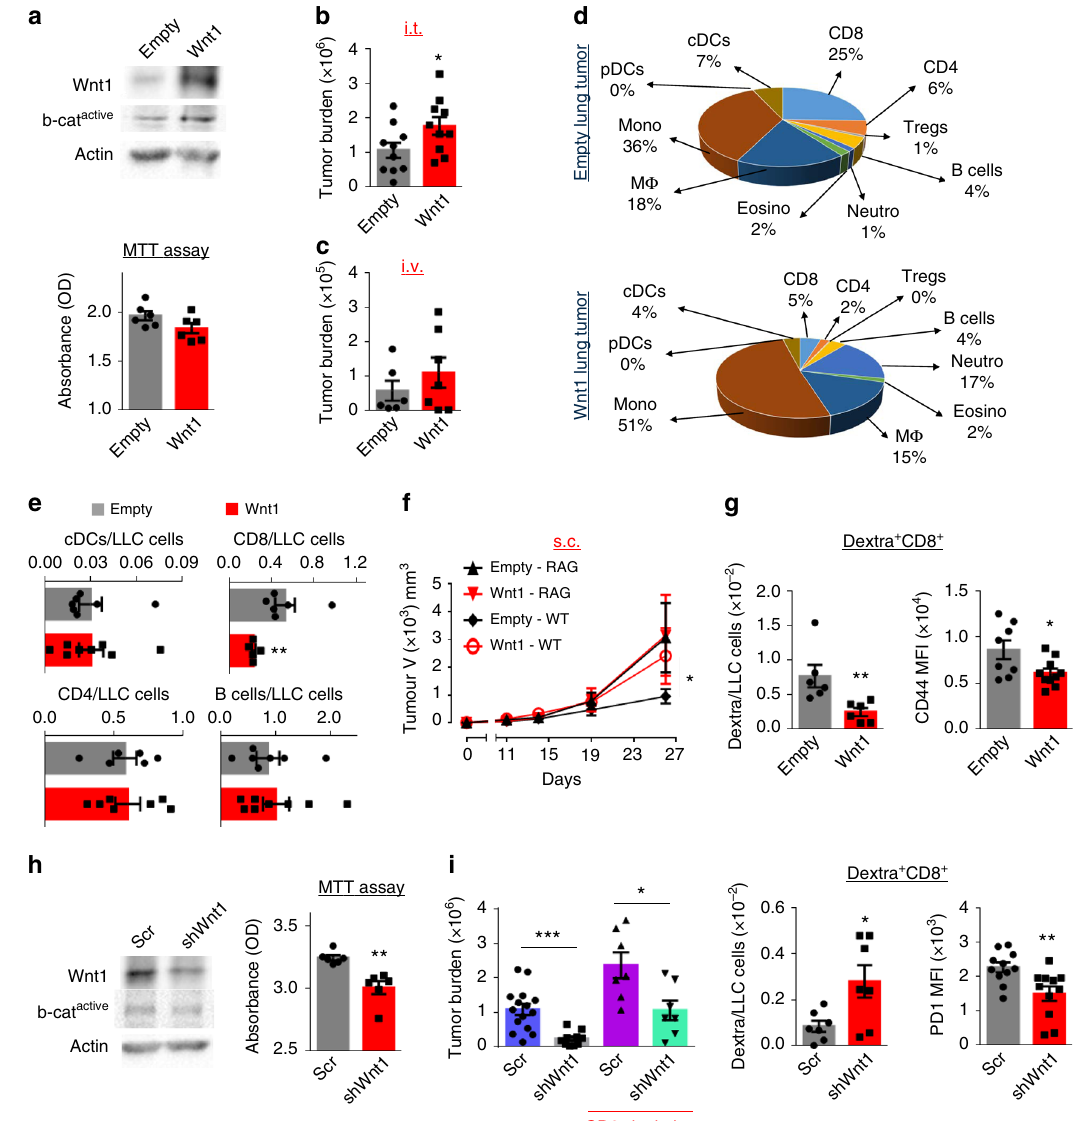
Fig. 2 Wnt1 impairs adaptive immune surveillance in syngeneic models. a Expression of Wnt1 and active b-catenin (western blot) in LLC cells transduced with Wnt1 (Wnt1) or Empty (Empty) viral vectors (Up). In vitro proliferation (MTT assay) (Bottom). b , c Tumor burden (total absolute number of LLC cells) after intrathoracic (i.t.) implantation or intravenous (i.v.) administration. d Cellular pro fi les of lung tumors. Pies depict mean percentages among CD45 + cells. e Numbers of intratumoral cDCs, CD8 T, CD4 T, and B cells per cancer cell. f Tumor growth after subcutaneous implantation of ovalbumin (OVA)-LLC cells in immunocompetent vs. immunode fi cient RAG mice. g Numbers of OVA-speci fi c (dextramer + ) T cytotoxic cells per cancer cell and T cell CD44 expression. h Expression of Wnt1 and active b-catenin (western blot) in LLC cells transduced with shWnt1 or Scramble viral vectors (left). In vitro proliferation (MTT assay) (right). i Tumor burden (total absolute number of OVA-LLC cells) after intrathoracic (i.t.) implantation in untreated vs. aCD8-treated mice (left). Numbers of dextramer + T cytotoxic cells per cancer cell and T cell PD1 expression (Right). a – i Error bars represent mean with SEM. b – g , i Cell numbers and pro fi les were assessed by FACS. Data are representative or cumulative of at least two independent experiments with 5 –